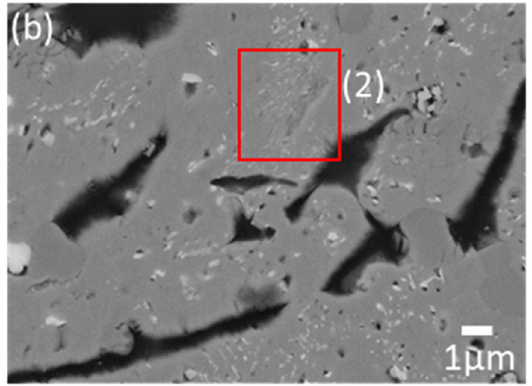
Figure 10. Comparison between the microstructures inside the magnet from the ( a ) conventional LME process and ( b ) FeB-added LME process ( × 5000 magnification). Table 3. EDS results for observing the composition of phases in (1) of Figure 10a and (2) of Figure 10b. Composition